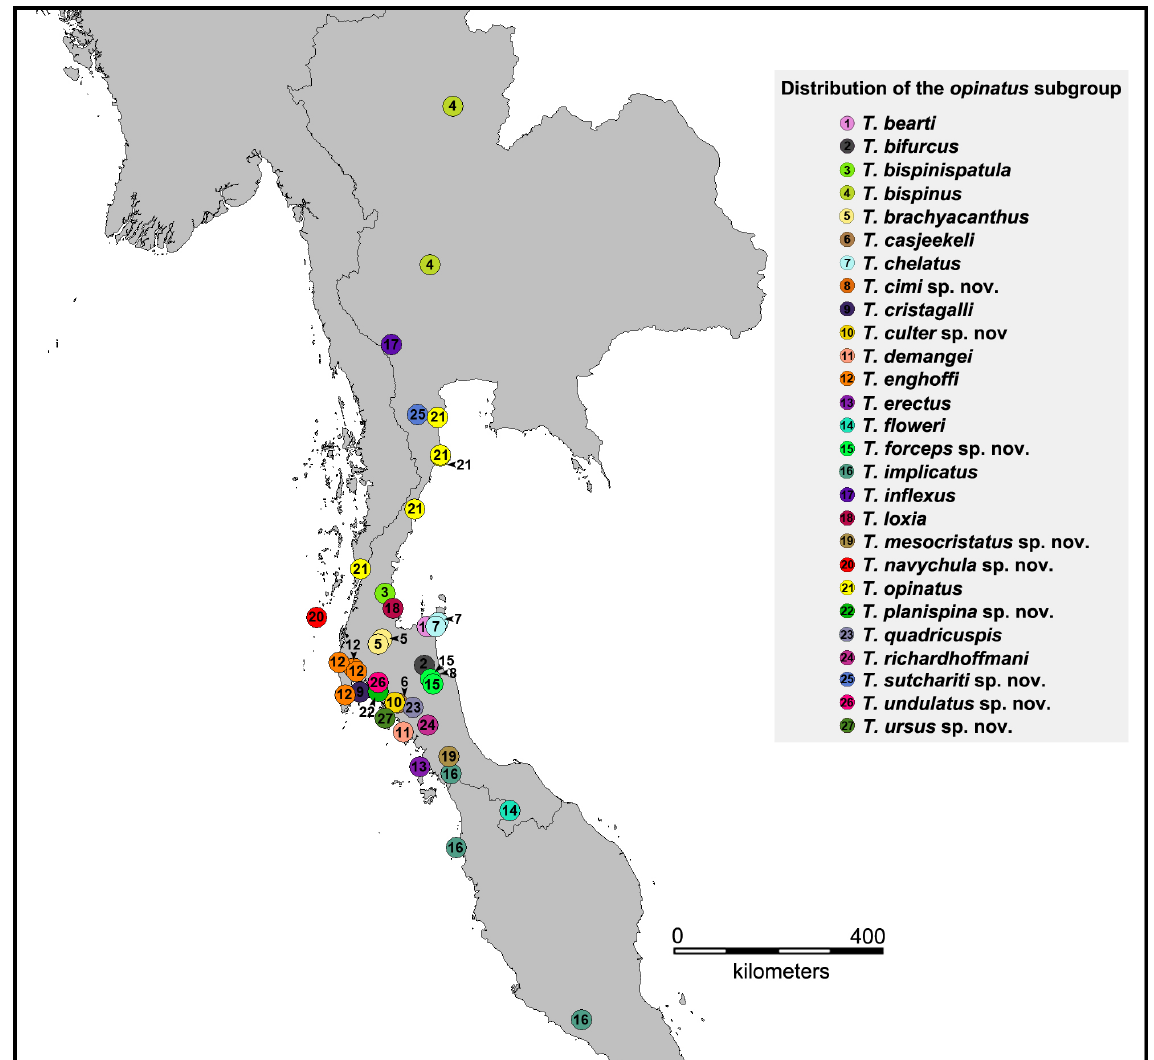
Fig. 12. Known distribution of the species of the T. opinatus